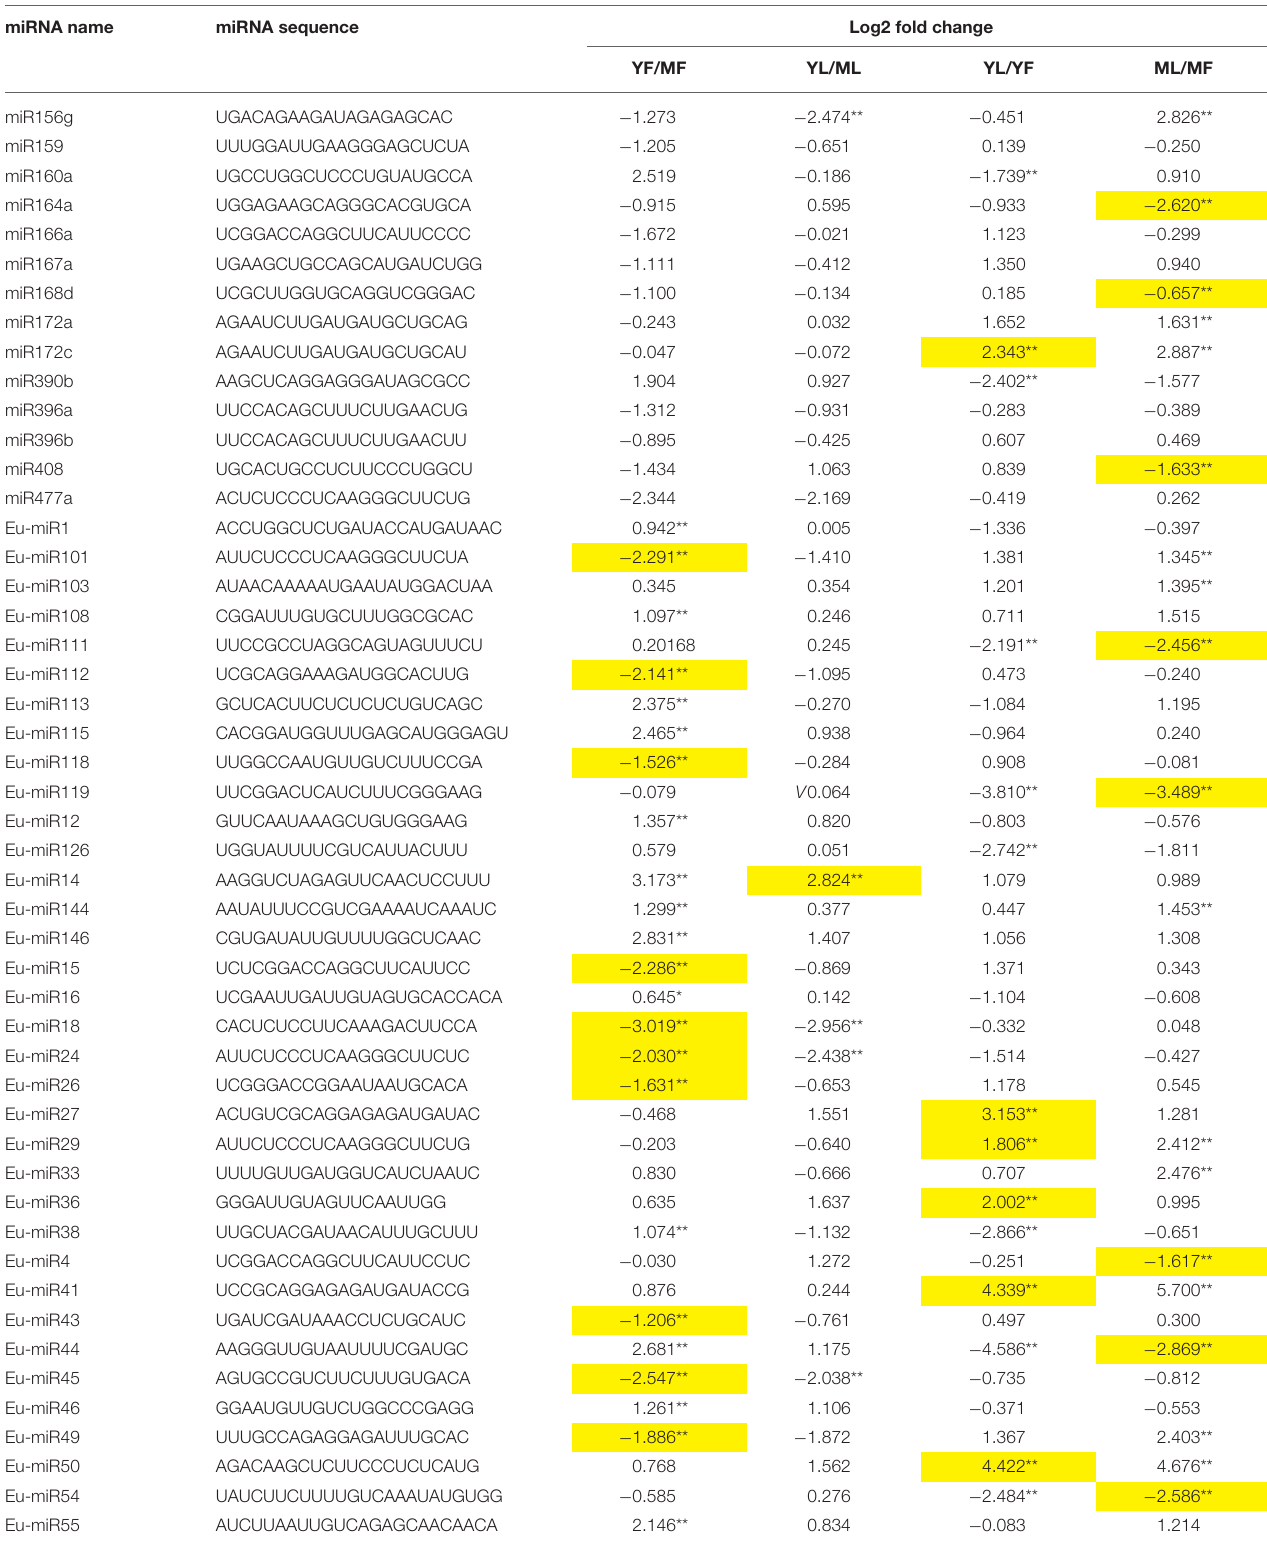
TABLE 2 | Differential expression of miRNA genes in YF vs. MF, YL vs. ML, YL vs. YF and ML vs. MF of Eucommia